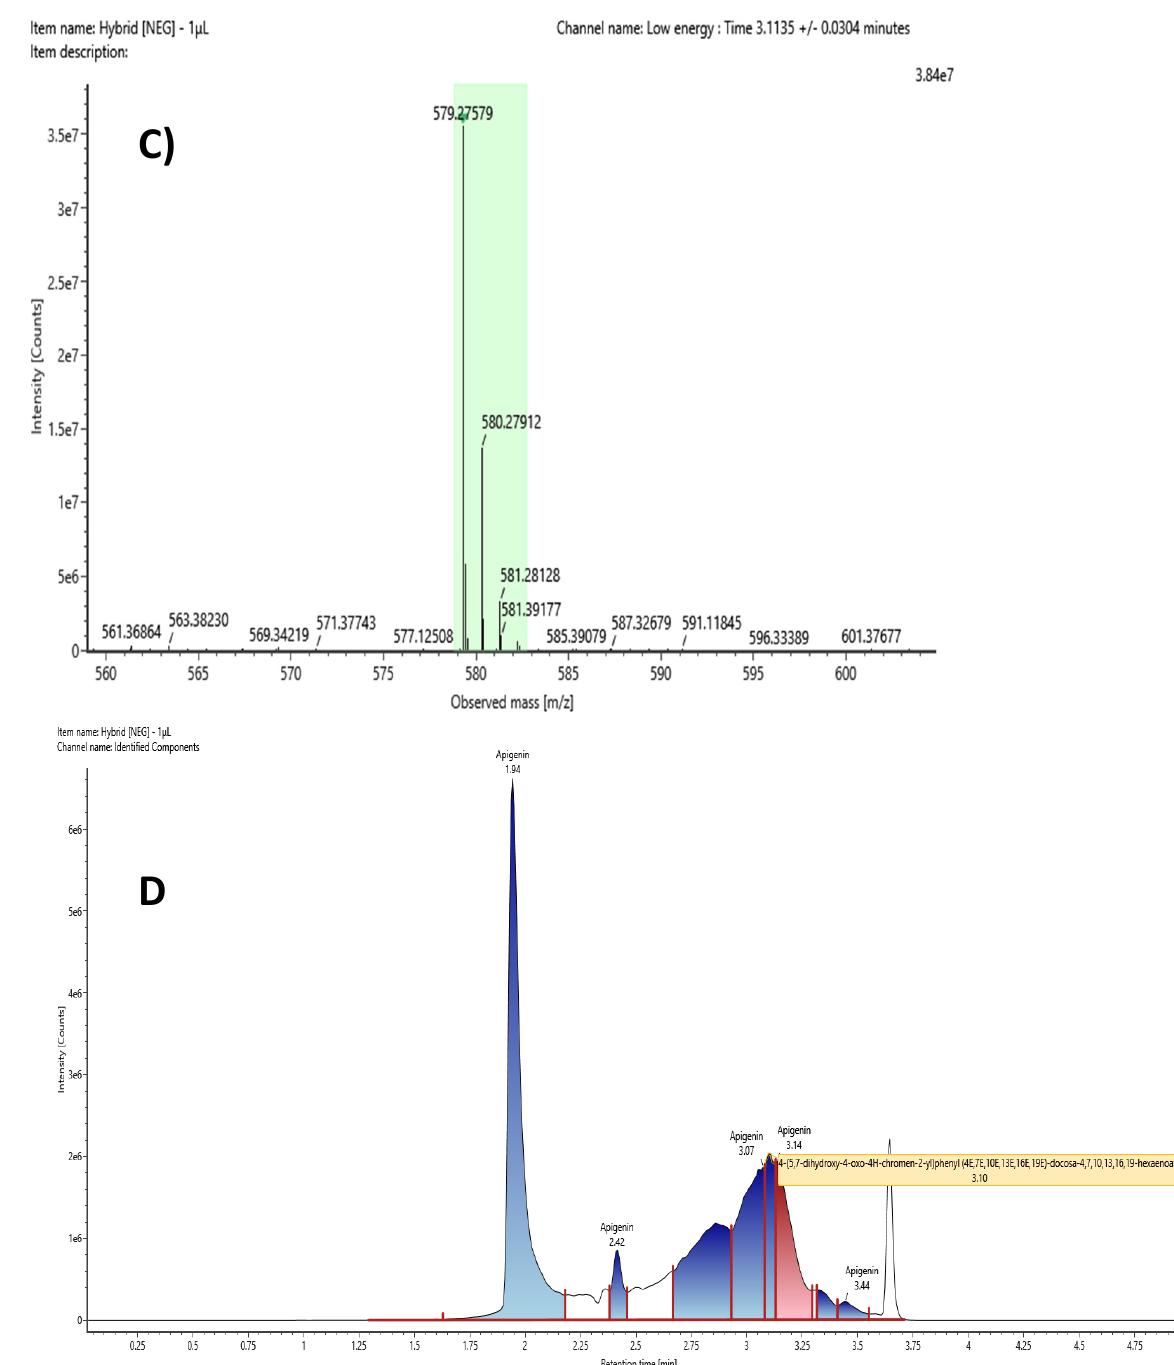
Figure 3. ( A , B ) 1 H and 13 C NMR spectrum, respectively, of 4 (cid:48) − DHA − apigenin in DMSO − d 6 ( θ = 25 ◦ C) ( C , D ) HRMS spectrum and chromatogram of 4 (cid:48) − DHA-apigenin; m / z 579.27. 2.3. Evaluation of the Antiplatelet Activity of Different Agents against ADP, AA, and TRAP-6 The activity of the hybrid was evaluated in vitro in platelet aggregation induced through P2Y12 and PAR-1 activation (using ADP and TRAP-6 as agonists, respectively), as well as through the COX-1 pathway, using AA as an agonist. The 4 (cid:48) -DHA-apigenin hybrid significantly inhibited platelet aggregation induced by all agonists in a dose-dependent manner, exhibiting IC50 values of 353 ± 36 µ M for AA, 362 ± 20 µ M for ADP, and 52 ± 12 µ M for TRAP-6 (Table